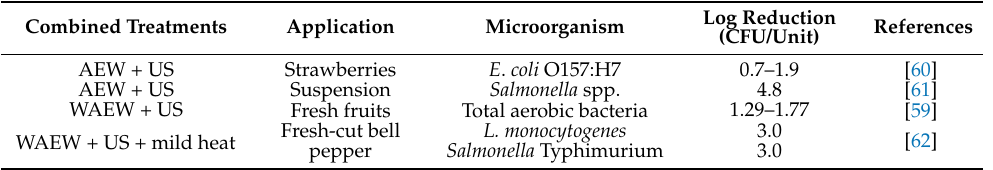
Table 4. Combinations of AEW and WAEW with ultrasound.